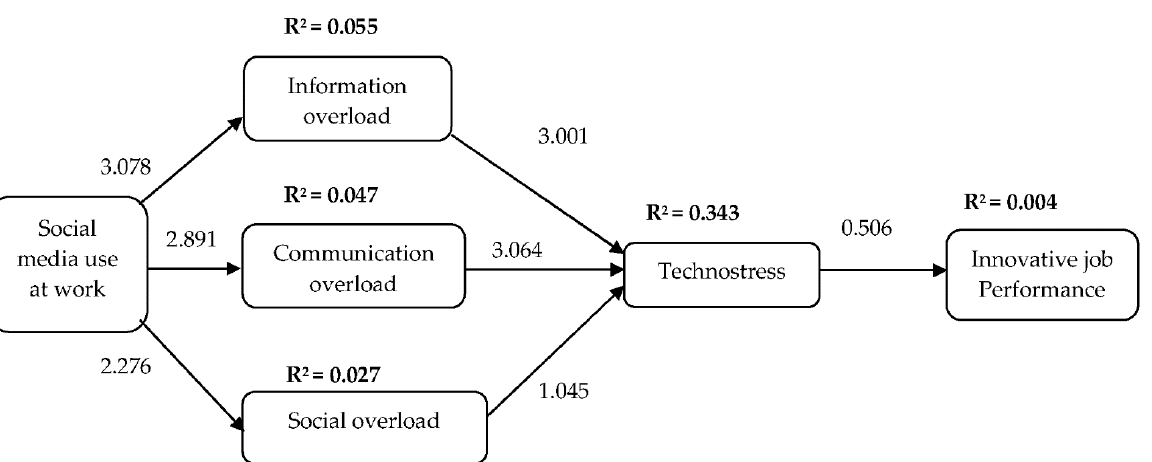
Figure 2. Structural Model. Table 7. The result of the coefficient determination (R Square), effect size (f Square), and predictive relevance (Q Square).